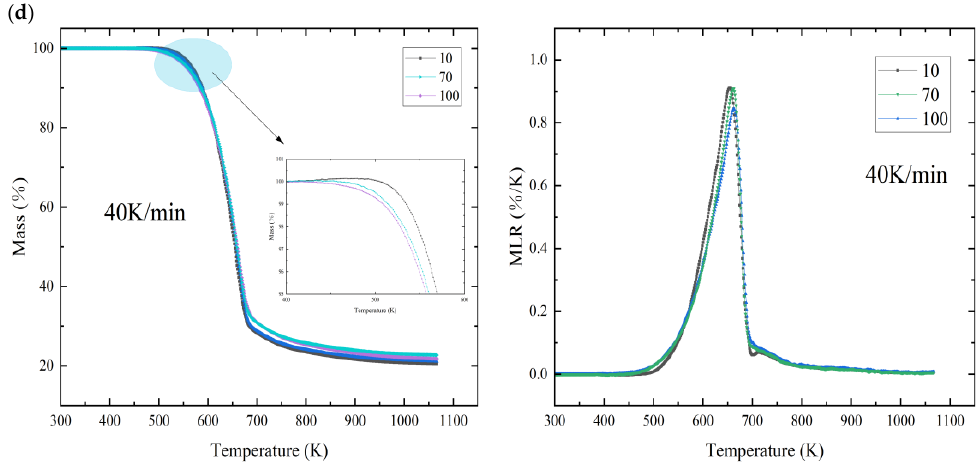
Figure 4. Mass loss (left) and mass loss rate (right) of Chinese fir at four natural aging times in nitrogen atmosphere). ( a ) 5 K/min; ( b ) 10 K/min; ( c ) 20 K/min; ( d ) 40 K/min. Table 1. Pyrolysis parameters of Chinese fir with different natural aging degree under different heating rates in nitrogen atmosphere.